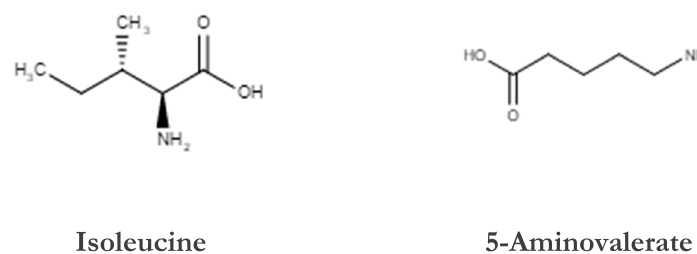
Figure 5. Molecular structures of valine, isoleucine, and 5-aminovalerate. For the purpose of TOCSY spectral interpretations, C1-Cn labels for each structure are arbitrary, although for this diagram they should be read from left-to-right. For valine, the 2 x γ -CH 3 , β -CH, and α -CH protons represent the C1A and C1B, C2 and C3 ones, respectively; for isoleucine, the δ -CH 3 , γ -CH 2 , β -CH, β -CH(CH 3 ), and α -CH protons represent the C1, C2, C3, C4A, and C4B ones, respectively; and for 5-aminovalerate, the α -, β -, γ -, and δ -CH 2 groups represent the C1, C2, C3, and C4 ones, respectively. 2D 1 H- 1 H COSY spectra reveal connectivities between a specified nucleus and its nearest neighboring ones only, for example between adjacent C1 and C2 nuclei, between C2 and C1 plus C3 nuclei in 5-aminovalerate. However, 2D 1 H- 1 H TOCSY spectra shown coupled nuclei linkages between up to 5 or more 1 H nuclei within a molecular chain, and therefore for 5-aminovalerate correlations between all these nuclei are clearly visible, as shown in Figure 6 below.